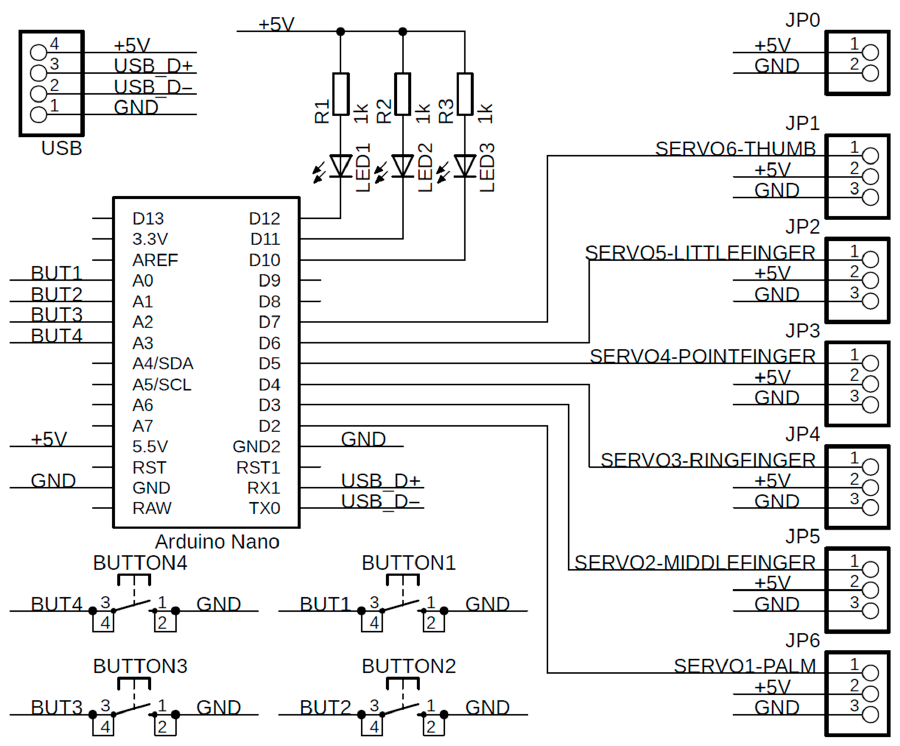
Figure 6. The electric schema draft of the custom-made circuit board.